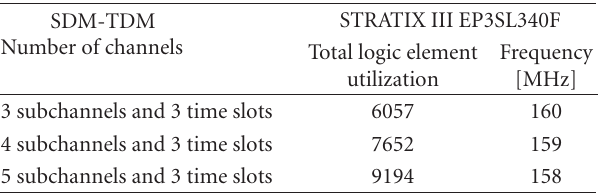
Table 6: Synthesis results SDM-TDM router (3 TC, 3, 4, 5